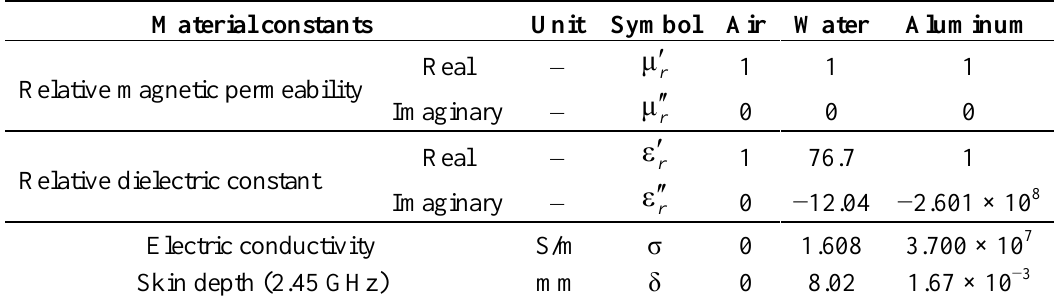
Table 2. Material constants in the micro-sized model.